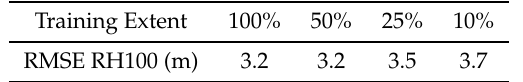
Table 7. RMSE (m) for predicted RH100 in terms of Area extent of learning data set